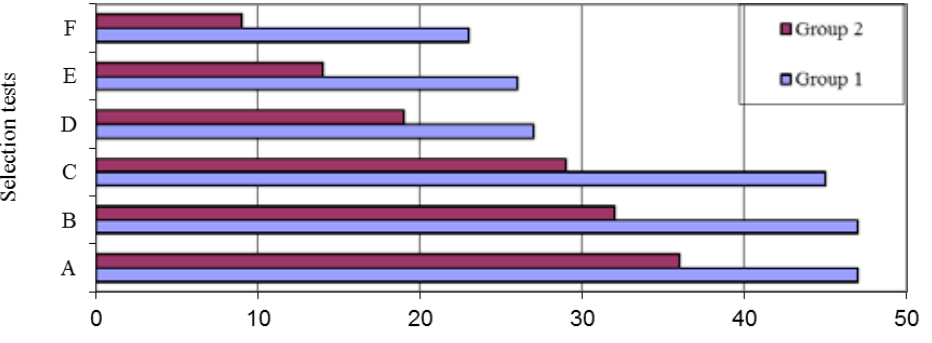
Fig. 2. Data on the number of athletes passed the